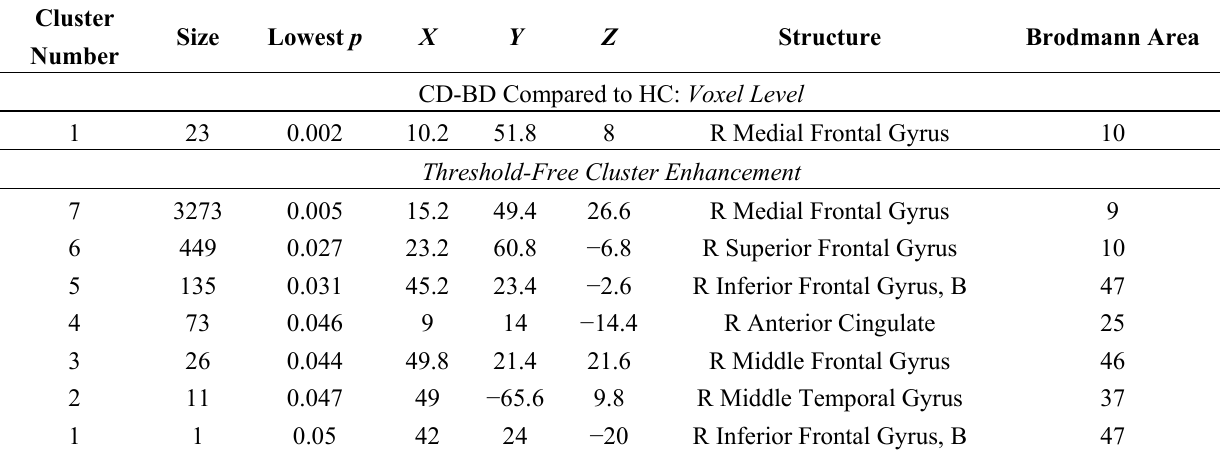
Table 2. Volumetric difference between